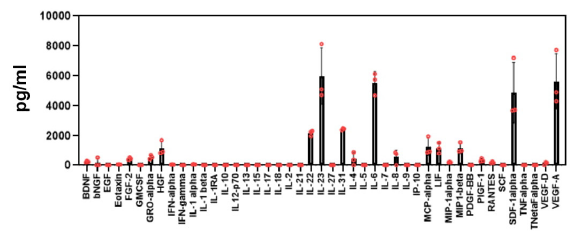
Figure 1. Mesenchymal stem cells (MSCs) from different donors secrete a similar pattern of cytokines and growth factors. Bone marrow derived MSCs (25,000/mL) of three donors were cultivated for 72 h. Supernatants were collected and subjected in duplicates to 43-parameter multiplex analysis as described in Materials and Methods. Data were grouped and mean values ± SD were determined.